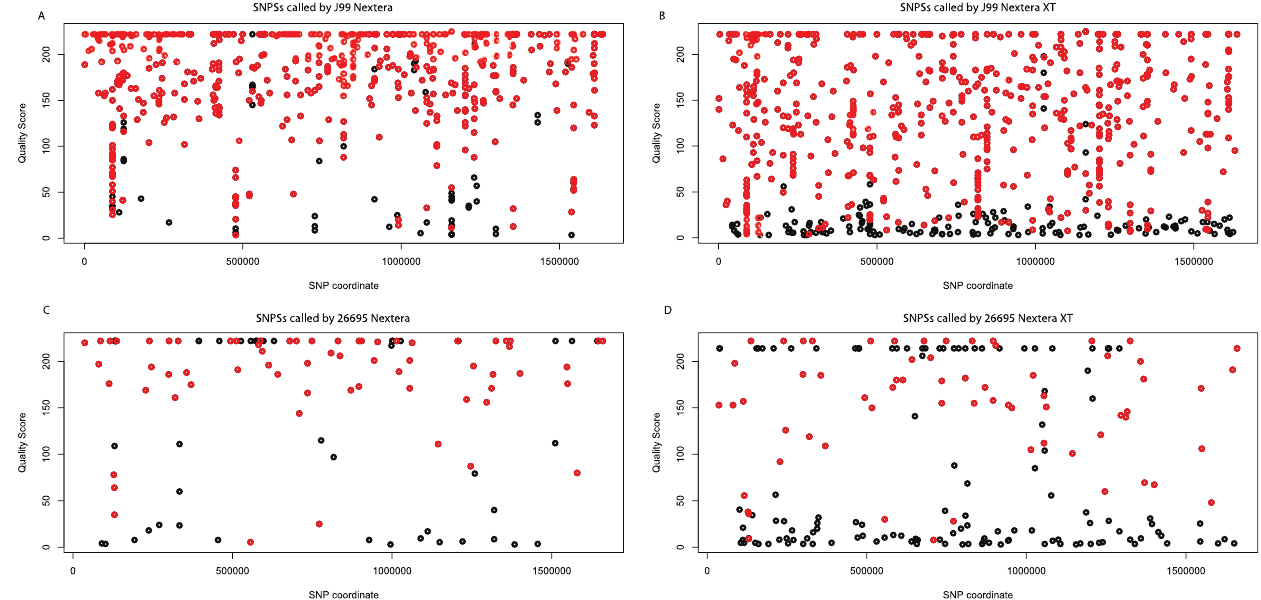
Figure 5. Plots of the SNP quality estimates. Red – Quality score of SNPs called by both Nextera and Nextera XT as the same variant, Black - SNPs called only by the corresponding technology, Nextera (left) and Nextera XT